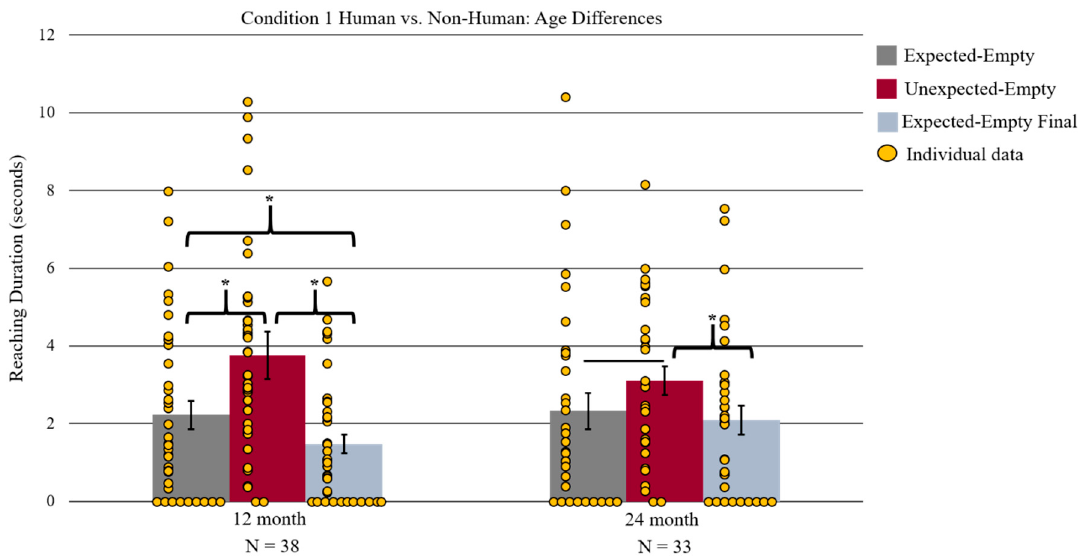
Figure 3. Depiction of the age separated two-way mixed measures ANOVA. Twelve-month-old infants reached significantly longer during the unexpected-empty relative to the expected-empty and expected-empty final outcomes. Additionally, infants showed longer reaching during the expected-empty than during the expected-empty final outcome. Twenty-four-month-old infants reached significantly longer during the unexpected- than during the expected-empty final outcome. Yellow circles represent each individual reaching data point. Error bars represent the standard error of the mean. The solid line represents a significant difference, which was not maintained following Bonferroni correction; * represents p < 0.05 Bonferroni corrected.